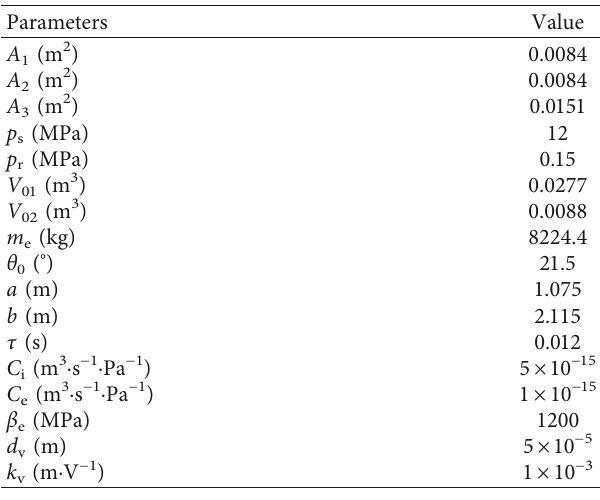
Table 1: Parameters of